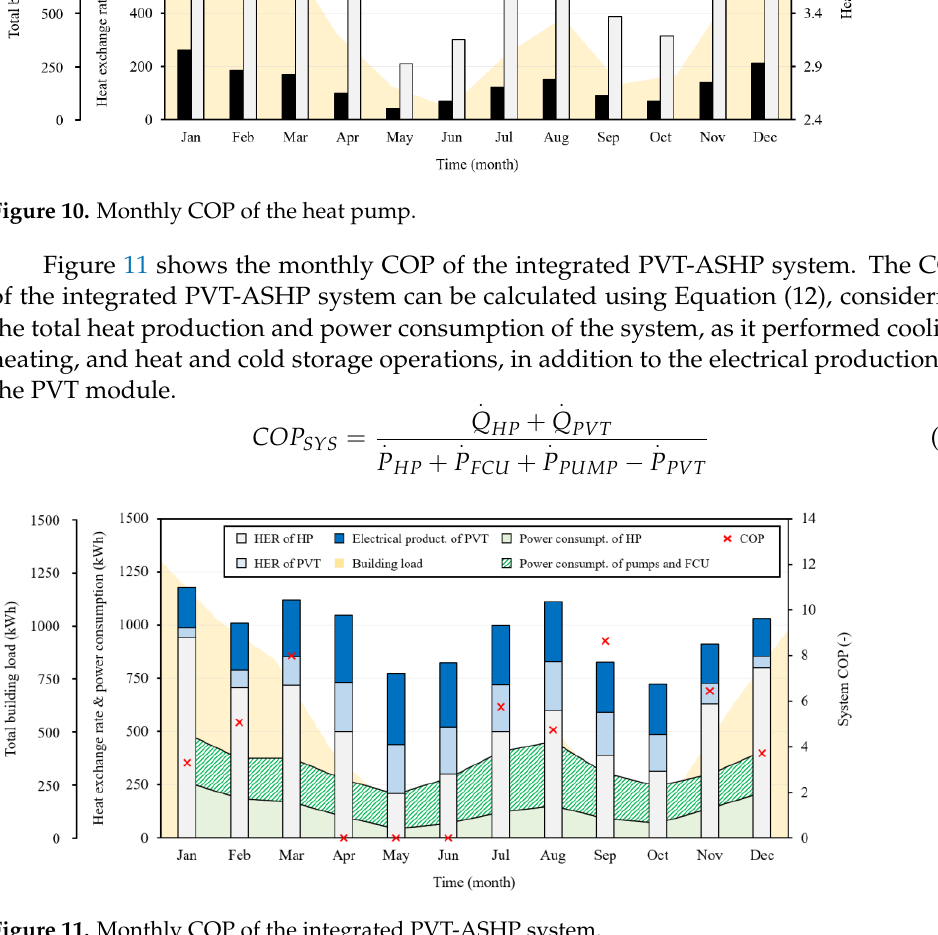
Figure 11. Monthly COP of the integrated PVT-ASHP system.